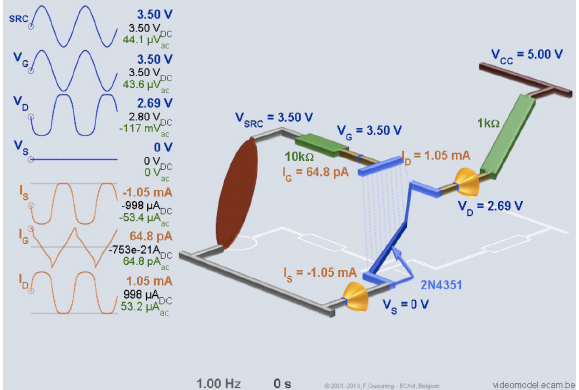
Figure 1. Example of an N-channel MOSFET transistor circuit, simu- lated by means of a videomodel. On the right side you can see the 3D model of the circuit, while the left side of the picture shows the values of parameters relevant to the circuit, at different points in